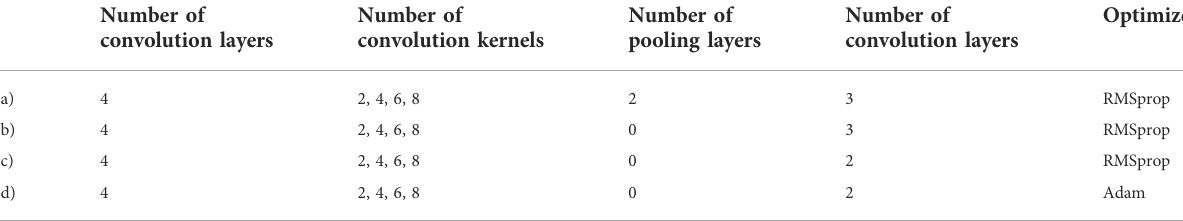
TABLE 2 The parameters with the lowest 95th percentile of relative prediction